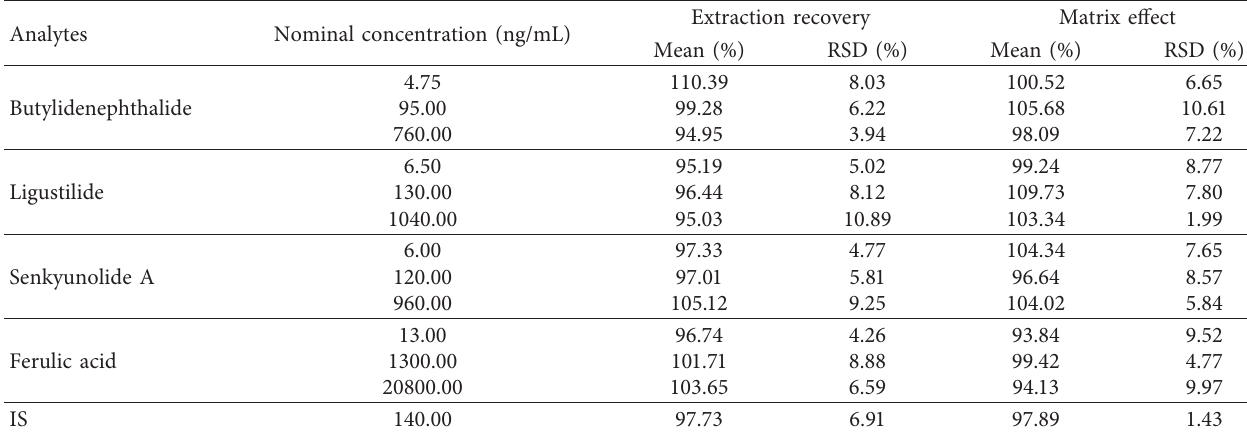
Table 3: Extraction recovery and matrix effect of butylidenephthalide, ligustilide, senkyunolide A, ferulic acid, and IS in rat plasma ( n � 6). Analytes